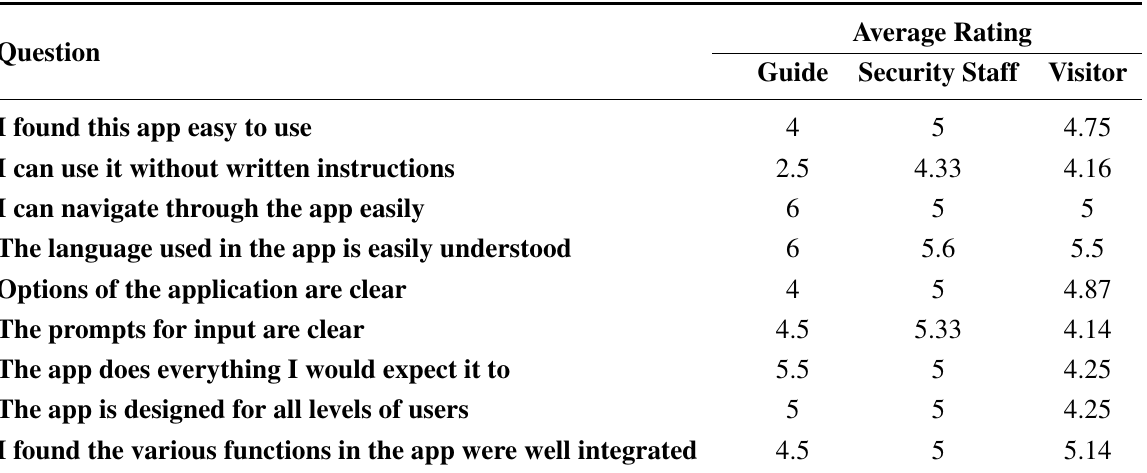
Table 3. Results for the second part of the questionnaire about the